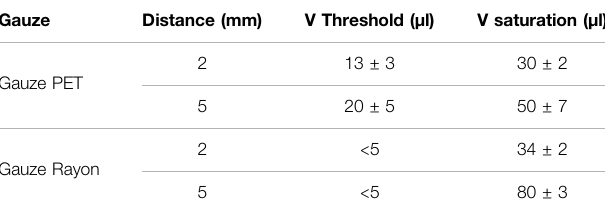
TABLE 1 | Moisture sensor parameters in single-layer